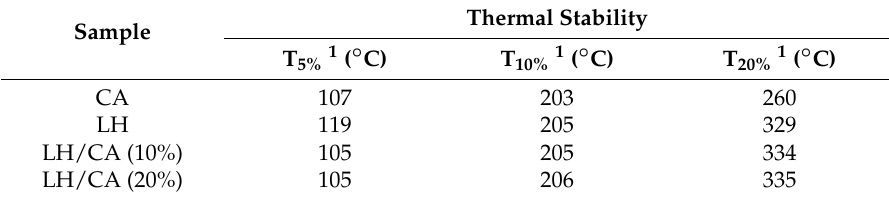
Figure 5. TGA ( a ) and DTG ( b ) profiles of CA, LH, LH/CA (10%), and LH/CA (20%). Table 2. Thermogravimetric analysis of hybrid pigments.